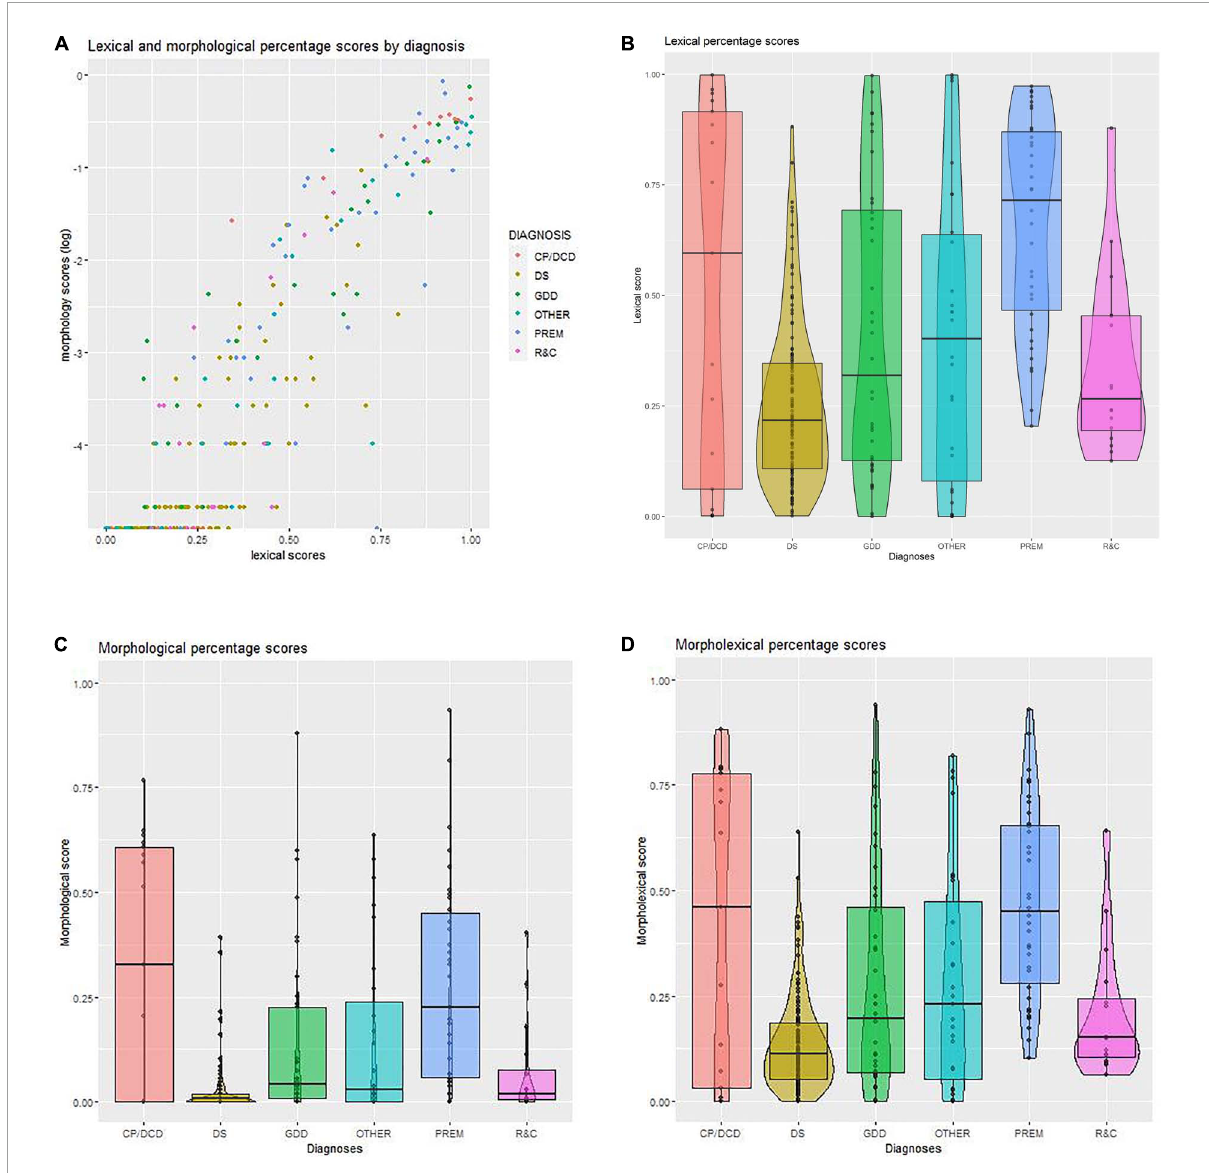
FIGURE1 (A) Lexical and morphological percentage scores by diagnosis. (B) Lexical percentage scores. (C) Morphological percentage scores. (D) Morpholexical percentage scores. CP/DCD, cerebral palsy/developmental coordination disorder; DS, Down syndrome; GDD, global developmental delay; OTHER, other syndromes than DS; PREM, prematurely born; R&C, disorders of relating and